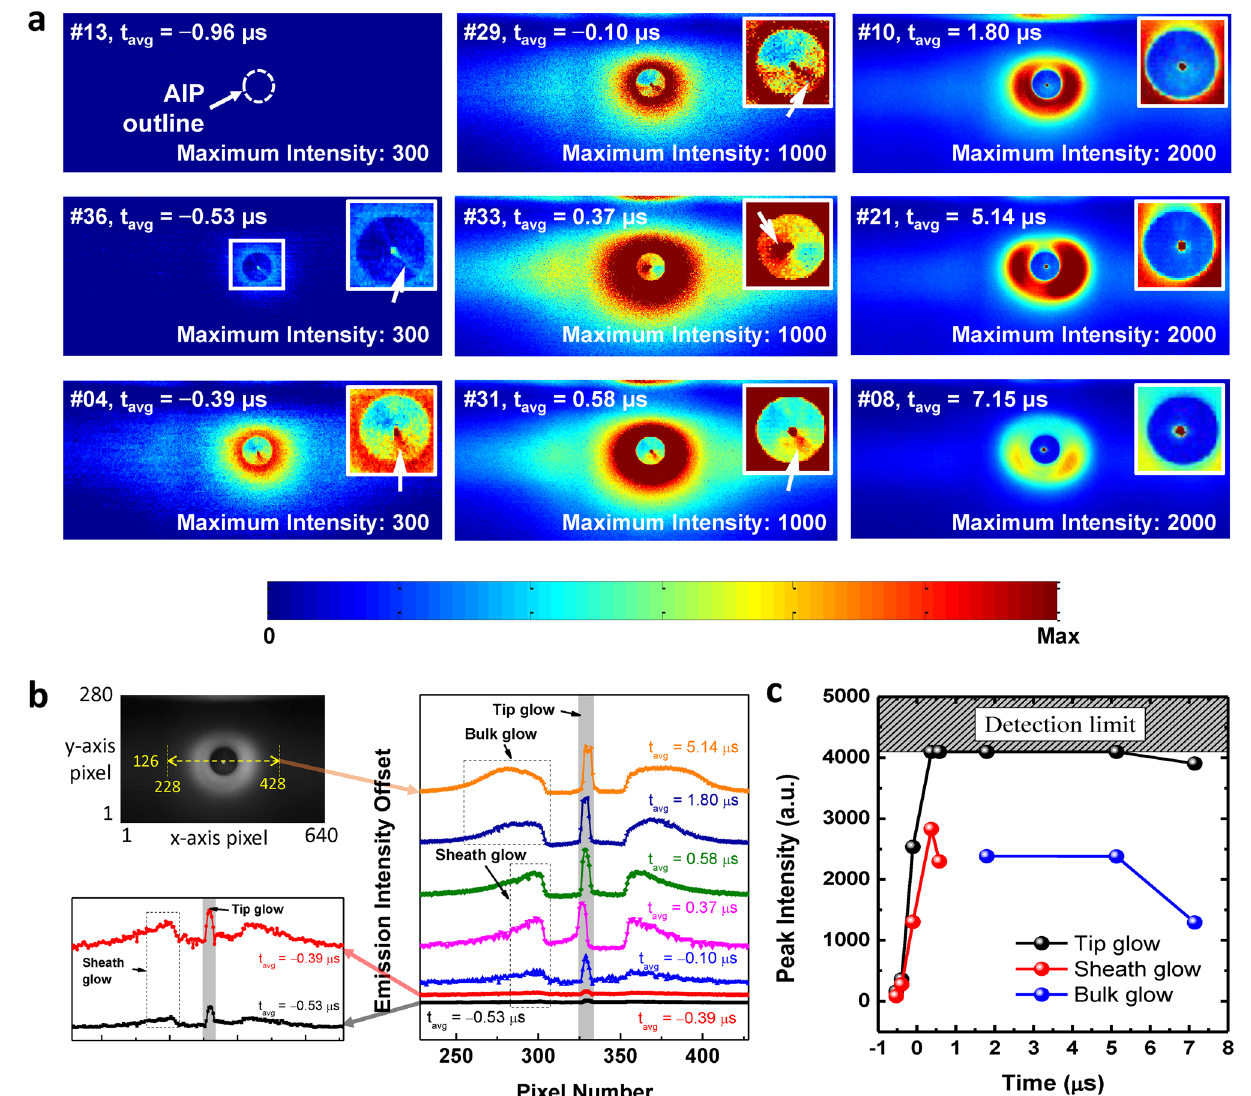
Figure 7. ( a ) Recorded images from a front-view measurement at a V AIP of − 75 V, P RF of 40 W, pressure of 166.4 mTorr, and argon injection of 50 sccm. ( b ) Intensity of the images in ( a ) at the y-axis pixel value of 126 and x-axis pixel values from 228 to 428. ( c ) Peak intensity of each glow type over